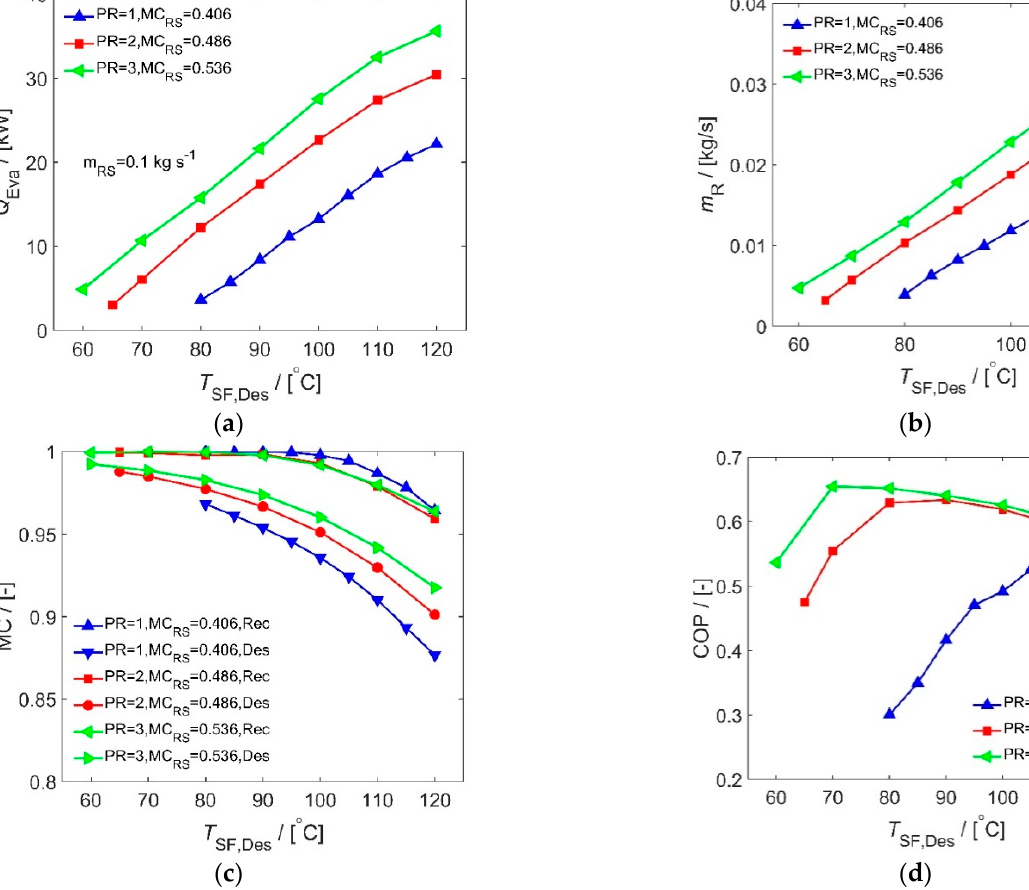
Figure 10. Performances of compression-assisted cycle as a function of heat source temperature and pressure ratio. Cycle performances are ( a ) Cooling capacity, ( b ) Refrigerant mass flow rate, ( c ) Vapour mass concentration at the outlet of the desorber and rectifier, ( d ) COP.